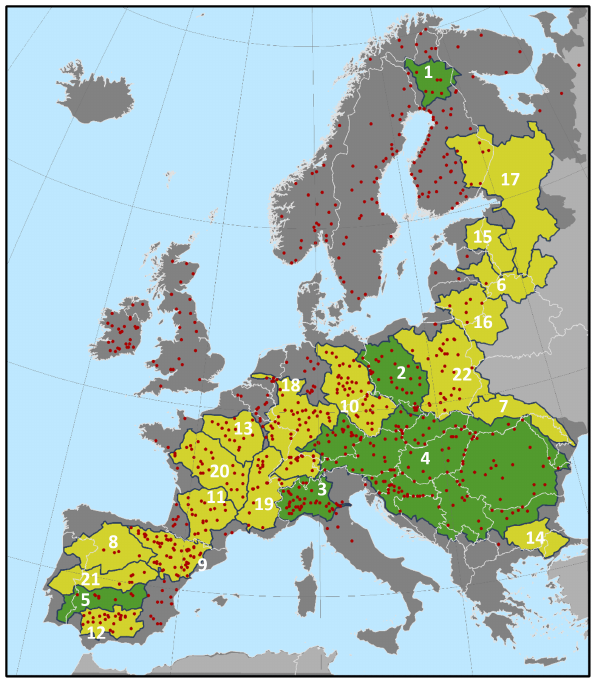
Figure 1. Map of the simulation domain with selected river basins analysed in the text (in green) and in the Supplement (in yellow). Discharge stations where the Lisflood model was calibrated are shown with red